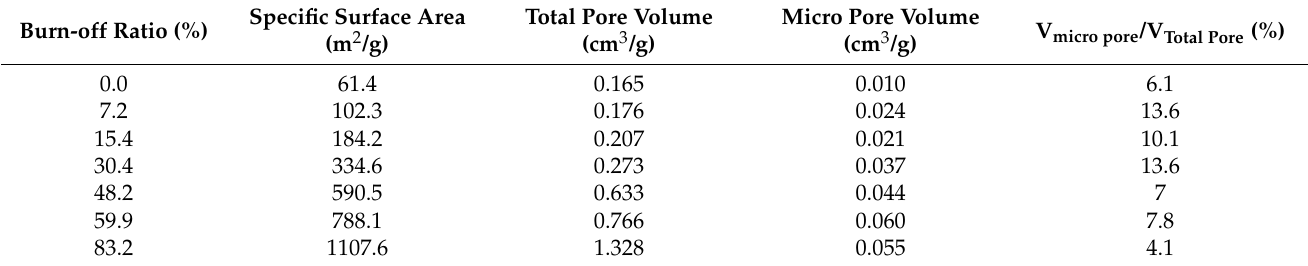
Table 2. Specific surface area and pore volume of activated carbon blacks obtained from BET